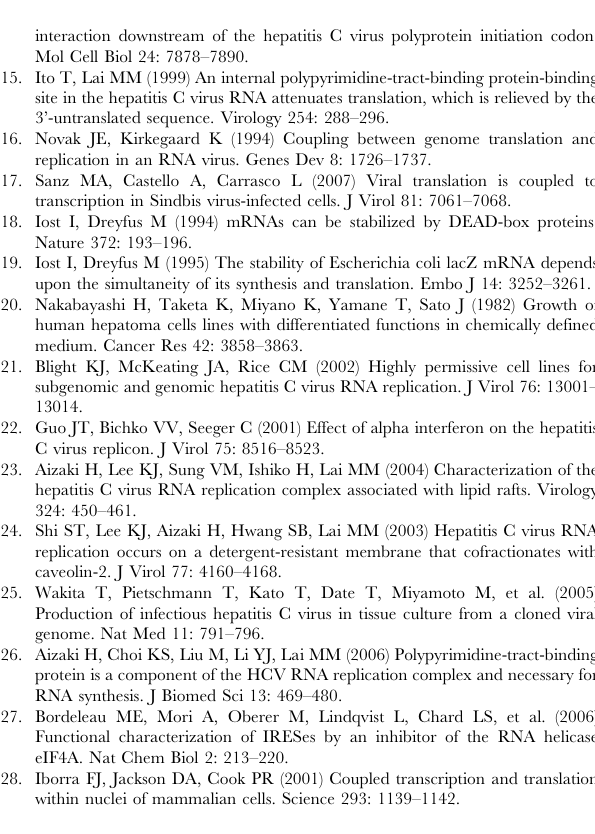
Figure S1 Benzothiadiazine treatment in Huh-N1b replicon cells. Huh7 and Huh-N1b cells pre-treated with actinomycin D, Benzothiadiazine (NS5B inhibitor), or combina- tion of both for 4 hours, and then labeled with 3 H-Uridine (A) or BrUTP (B). RNA synthesis was detected by RNA precipitation followed by scintillation counting (A), by immunofluorescence staining (B), or by real-time RT-PCR (C, D). Autoradiography of